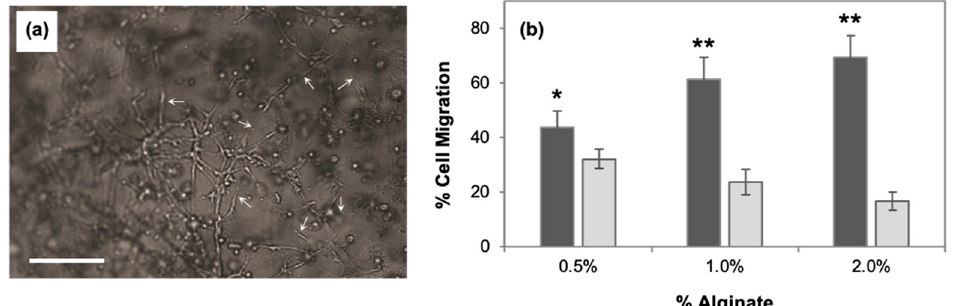
Figure 1. ( a ) Representative phase-contrast image showing migrated U87 cells into RGD-modified alginate scaffolds on day 3. The scale bar depicts 100 µm. The image shows that cells extended processes in RGD-modified alginate (as indicated by the white arrows). ( b ) Migration of U87 cells into 0.5%, 1%, and 2% RGD-modified (dark grey) and unmodified (light grey) alginate gels after three days. Error bars represent the standard deviation of three biological samples. Statistical significance was independently evaluated for each RGD-modified alginate condition relative to the corresponding unmodified alginate condition using a two-tailed t -test evaluated with a 95% (*) or 99% (**) confidence interval.